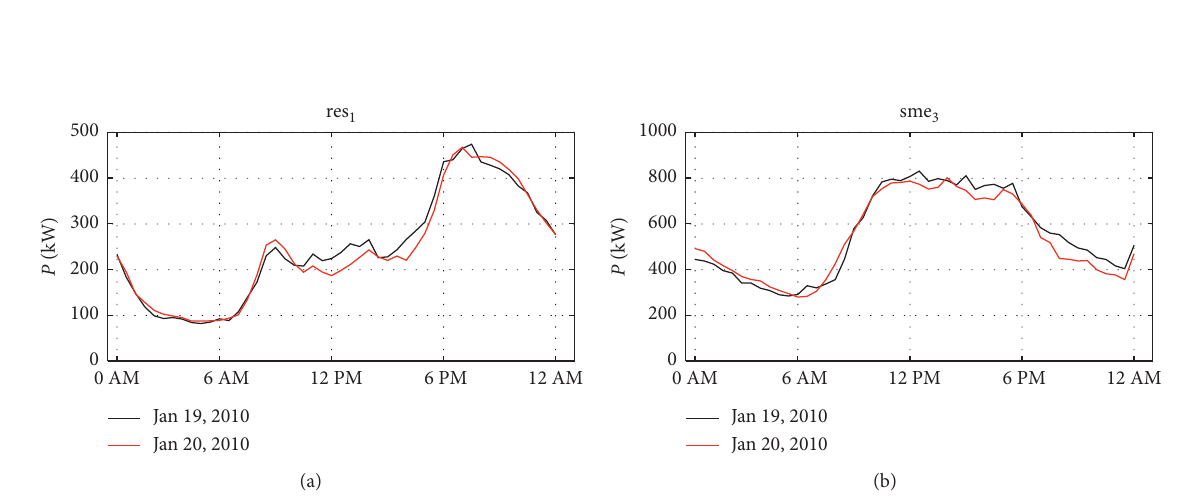
Figure 5: Aggregation of residential (a) and SME (b)